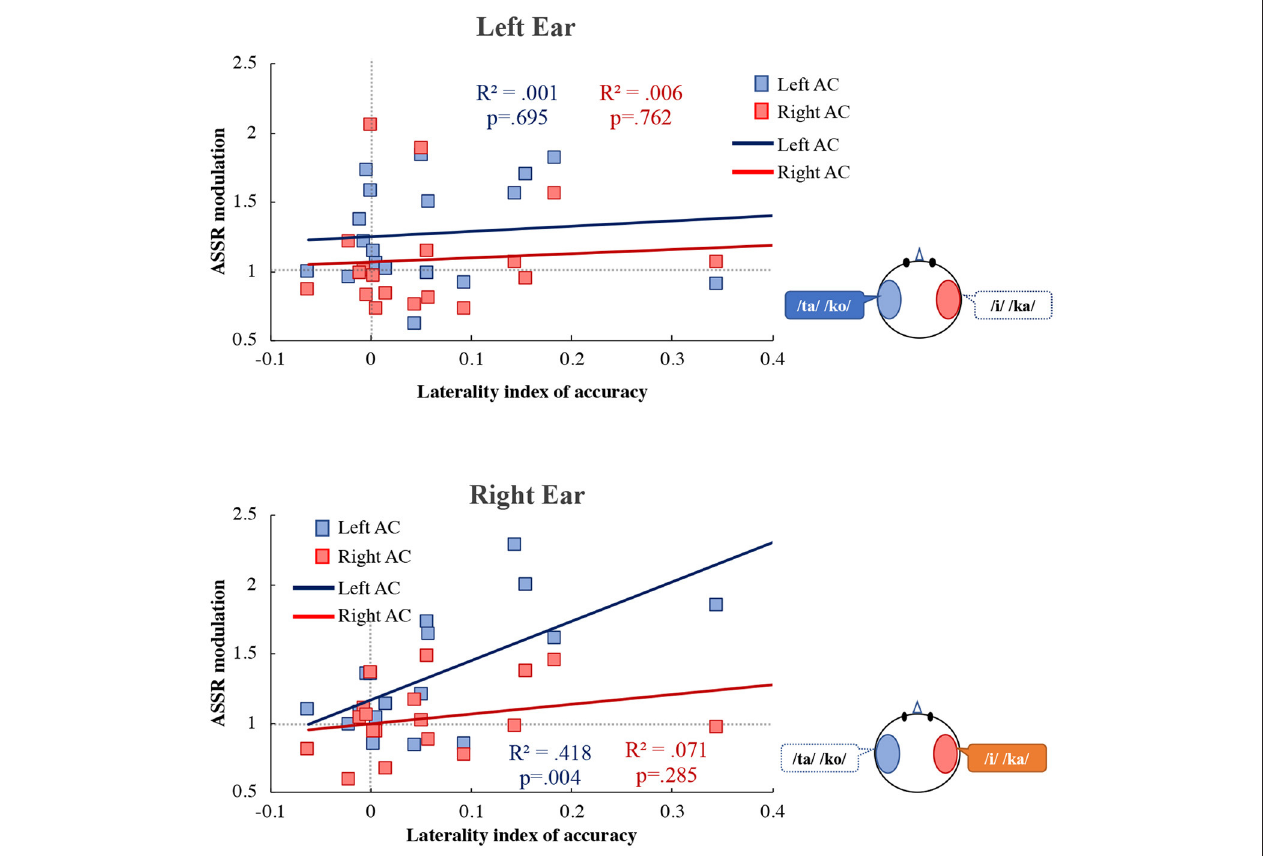
FIGURE 6 | Correlation between the laterality index of accuracy and the ASSR modulation in the left (blue) and right (red) auditory cortex (Left AC or Right AC) to the left (upper figure) and right (lower figure) ears during the dichotic listening task. X-axis shows the laterality index of accuracy. Y-axis shows the ASSR modulation. The more to the right, more REA in the accuracy is indicated, and to the left, the LEA is indicated. R 2 indicates determination coefficient. ASSR, auditory steady-state response; AC, auditory